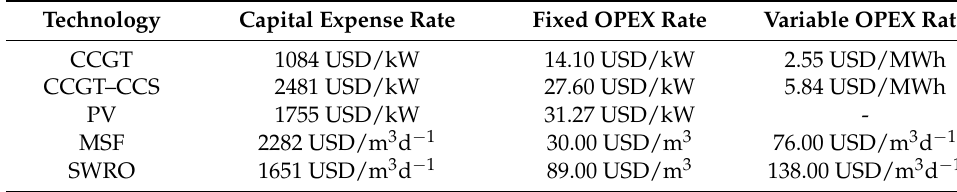
Table 6. Capital and operating cost rates for all production